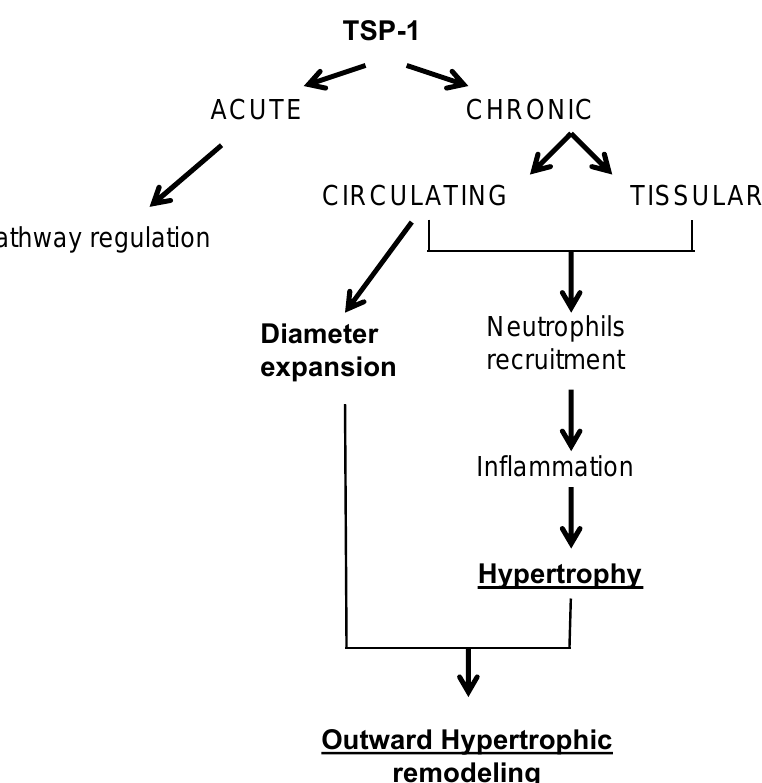
Figure 7. Schema of TSP-1 implication in mesenteric resistance arteries remodeling induced by a chronic increase in blood flow.